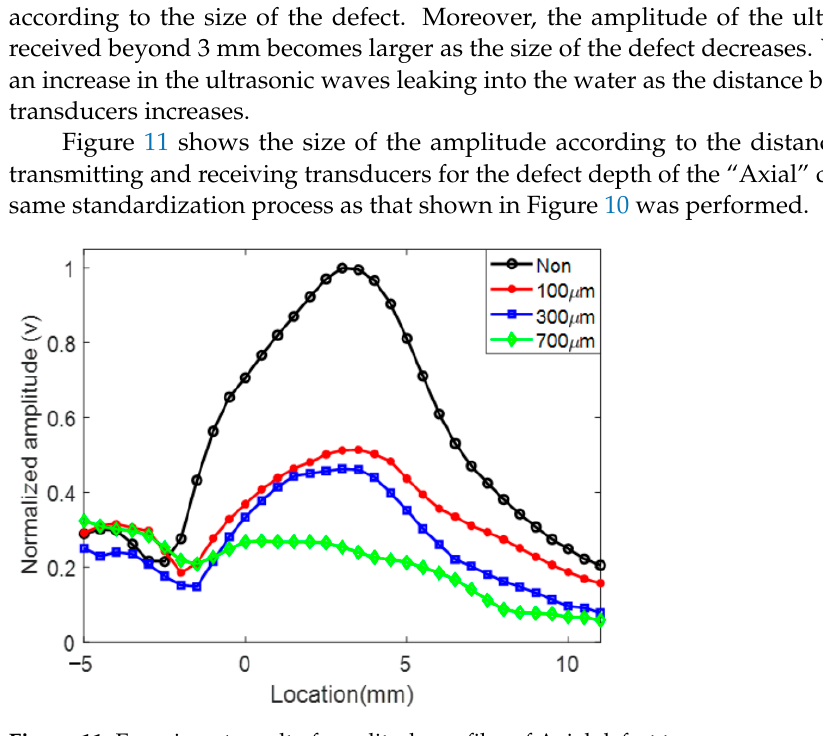
Figure 10. Experiment result of amplitude profiles of Circum defect type.